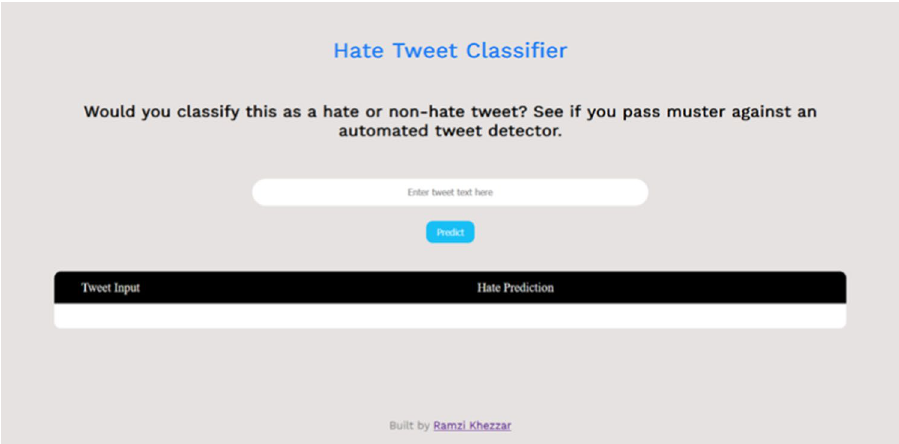
Fig. 8 Web application user